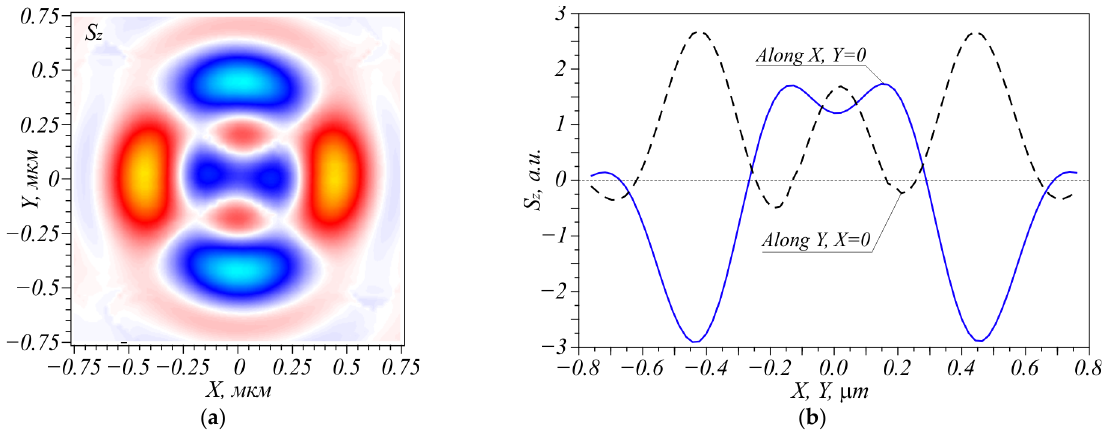
Figure 3. ( a ) z -Axis projection Sz of the SAM vector and ( b ) its profiles along the x - and y -axes.